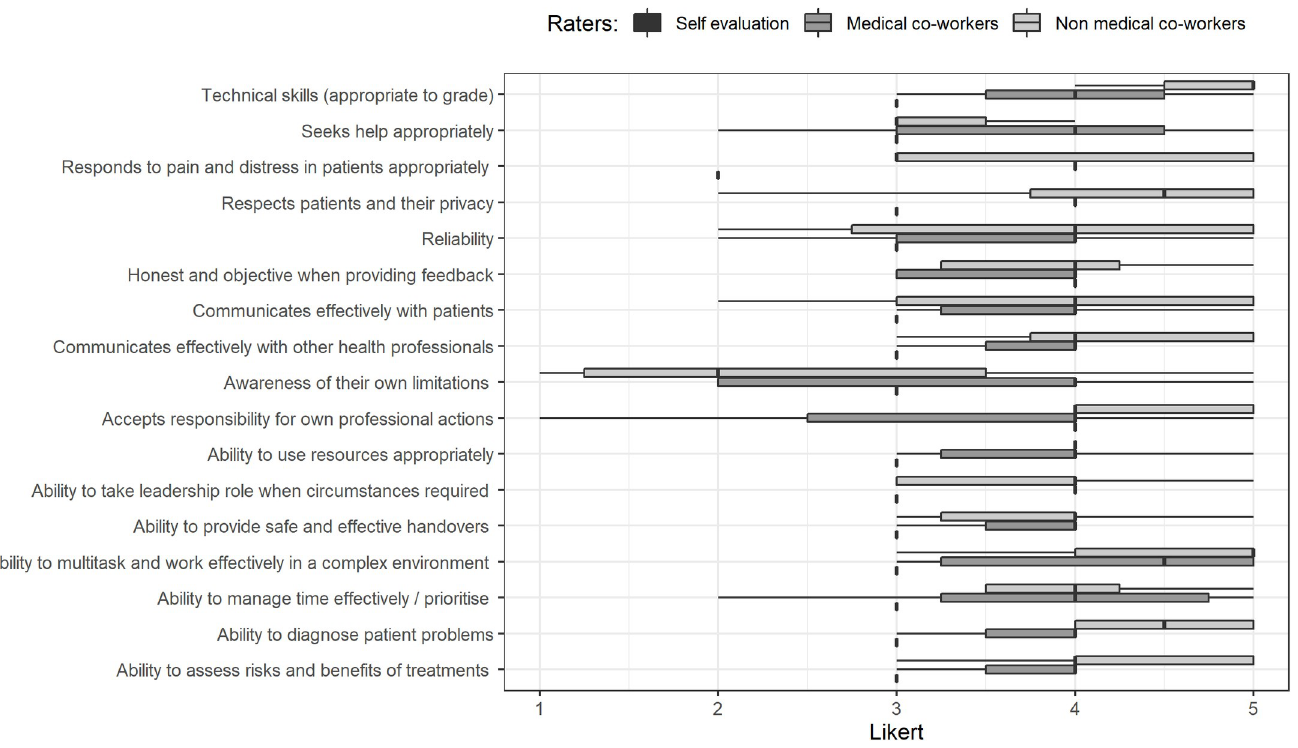
Fig 1. An example of the graphical feedback provided to each